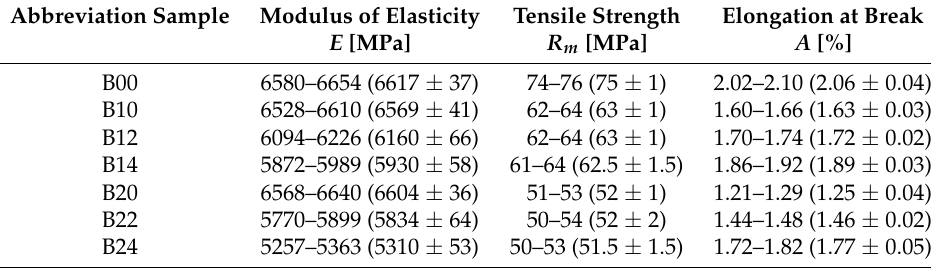
Table 3. Type “B” hemp fabric reinforced samples: lower and upper values (arithmetical average value and deviation value) for the elasticity modulus, tensile strength, and elongation at